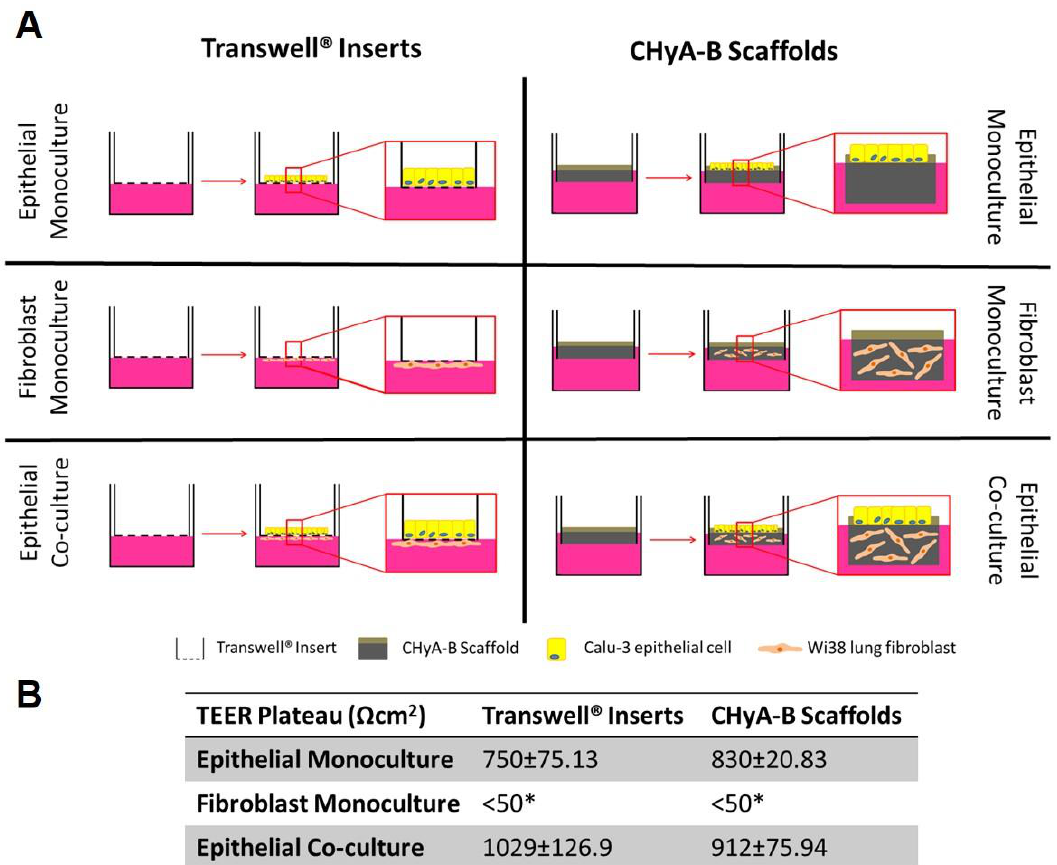
Figure 1. Evaluation of epithelial barrier integrity in air liquid interface (ALI) culture models used for exposure studies. ( A ) Calu-3 epithelial monocultures, Wi38 fibroblast monocultures, and Calu-3 Wi38 epithelial co-cultures on Transwell ® inserts and CHyA-B scaffolds grown under ALI conditions for 14 days. ( B ) Average TEER values of Calu-3 epithelial cell barriers following plateau of electrical resistance (day 10, 12, and 14). Results displayed as mean ± SEM ( n = 7). (* TEER measurements for fibroblast monocultures on Transwell ® inserts and CHyA-B scaffolds were performed as n = 2)